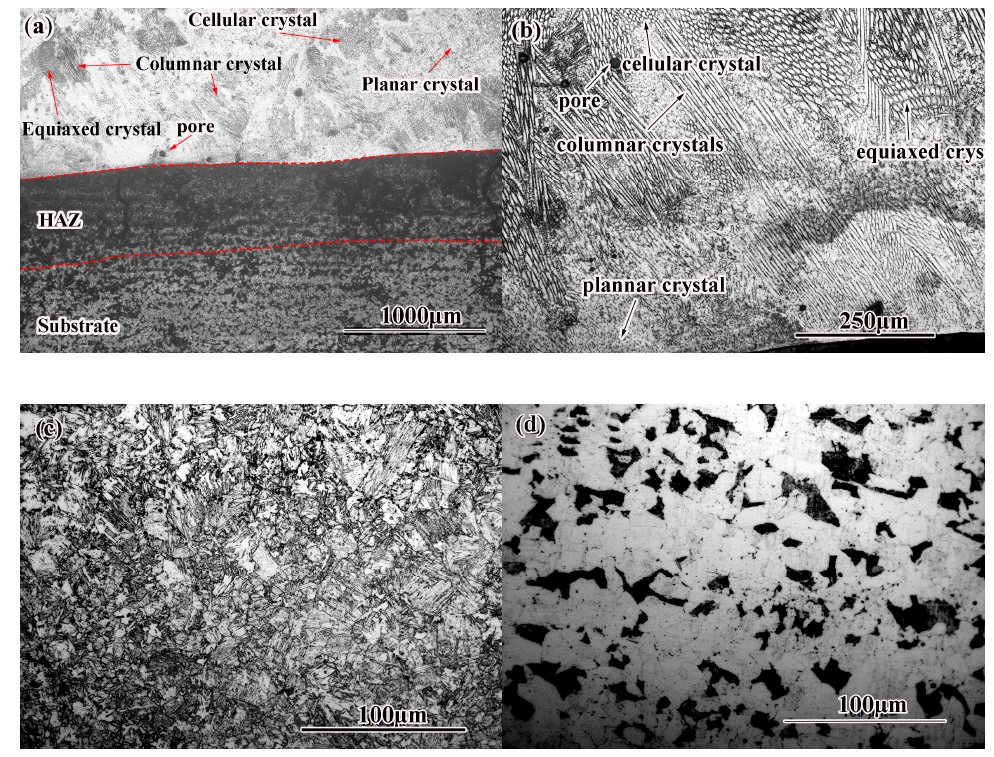
Figure 5. Microstructure of specimens under the optical microscope: ( a ) cross-sectional; ( b ) cladding; ( c ) HAZ; ( d ) G20Mn5QT.